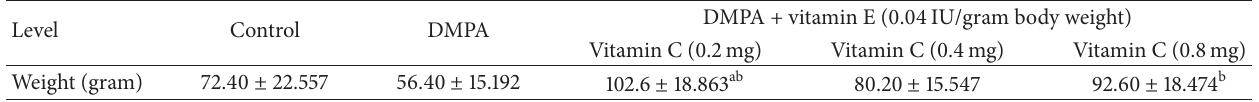
Table 1: The ovarian weight in each experimental group.